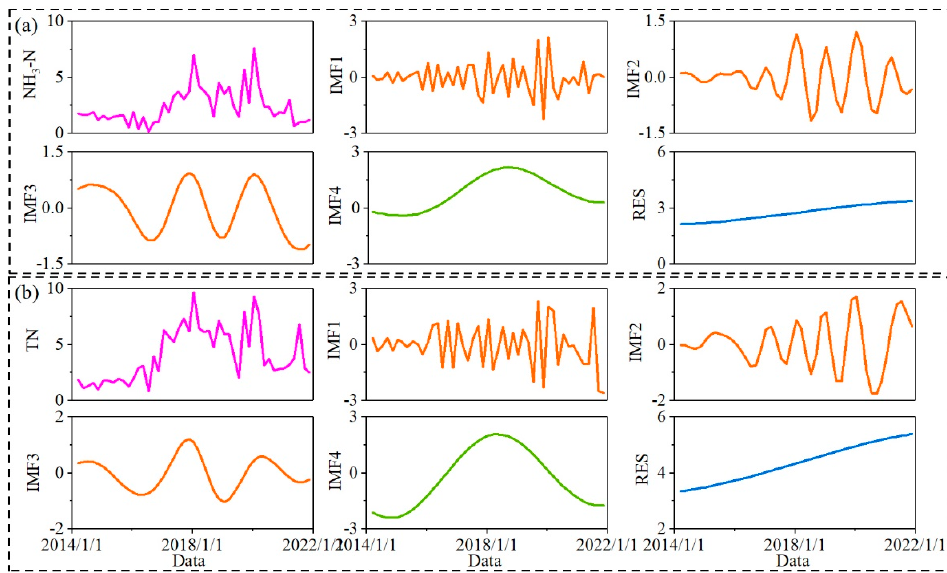
Figure 5. The decomposition of water quality sequences by the CEEMDAN method. ( a ) NH 3 -N; ( b ) TN.